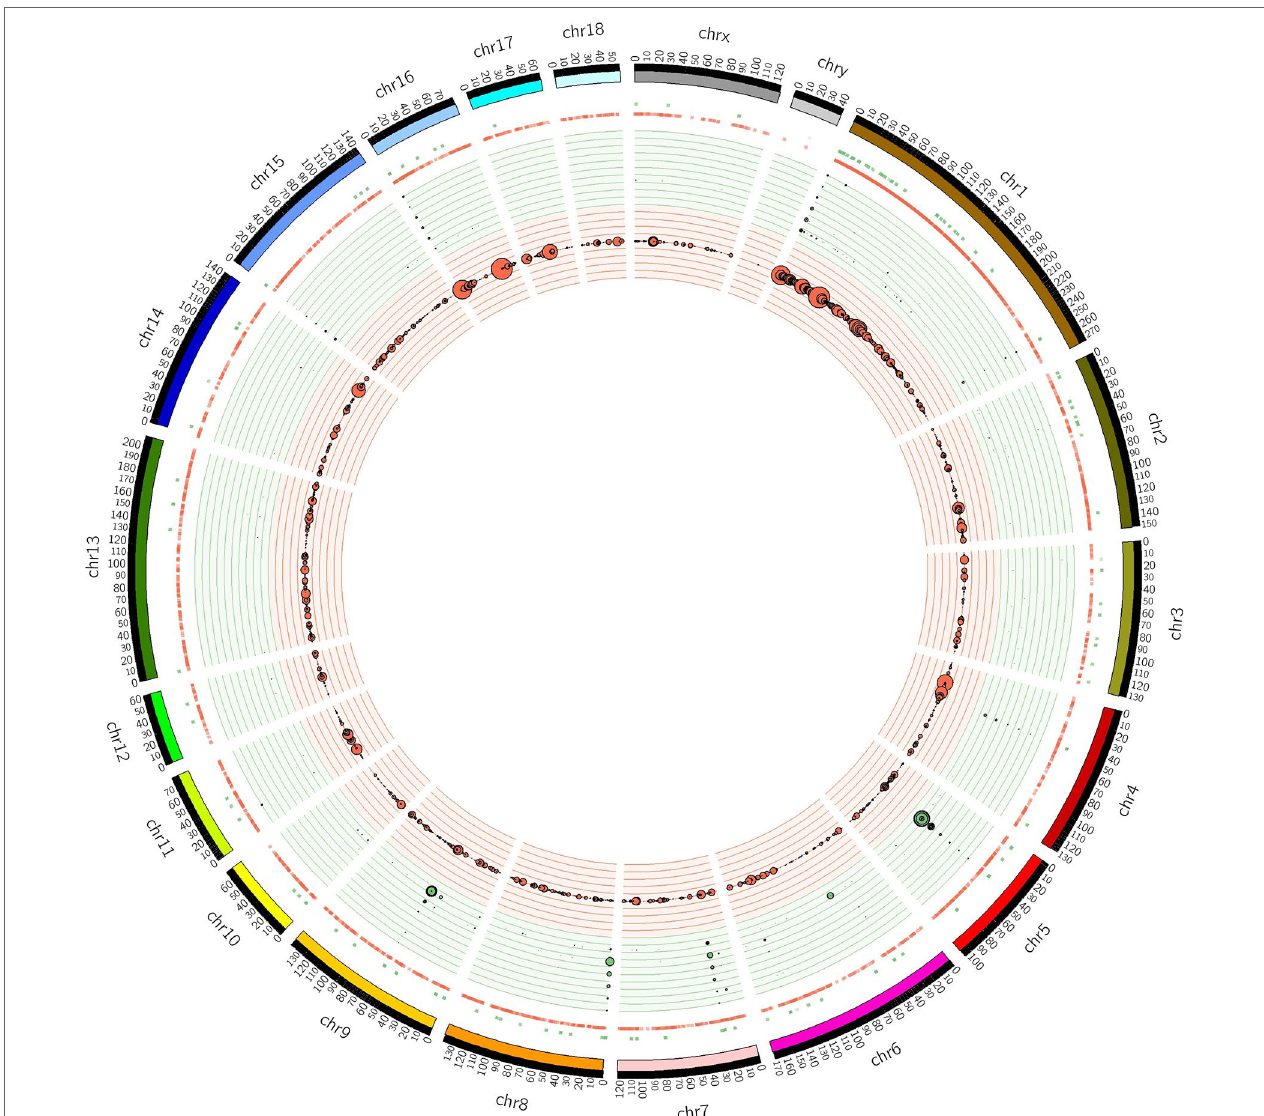
FIGURE 1 | Positions of CNVRs identified from the 240 sequenced swine genomes in Circos format (Krzywinski et al., 2009). The outer ideogram runs clockwise from chromosome 1 to chromosome Y with labels in Mb of physical distance. The copy number data are represented in the inner tracks. The two innermost tracks show scatter plots of the CNVR, where the red track shows copy number loss and the green track shows copy number gain. Concentric circles within these tracks indicate y -axis values in the scatter plot. The 10 concentric circles in the red track mark values 0 ≤ y < 2, with 0 being the innermost track, while the 11 concentric circles in the green track mark values 2 ≤ y ≤ 8. The size of the dot in the scatter plot is proportional to the number of samples containing the CNVR. The other track shows a heat map that indicates the parts of the genome that contain copy number gain and loss. This plot simply collapses the scatter plot values onto a single radial